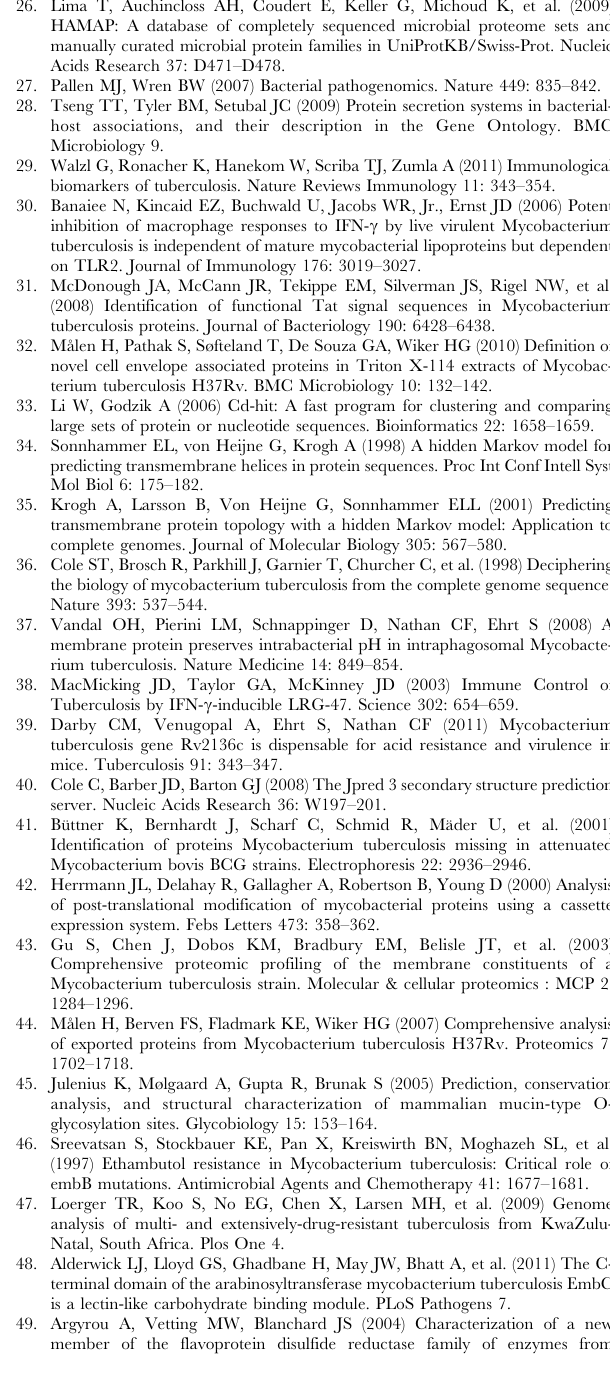
seven selected tuberculosis strains.